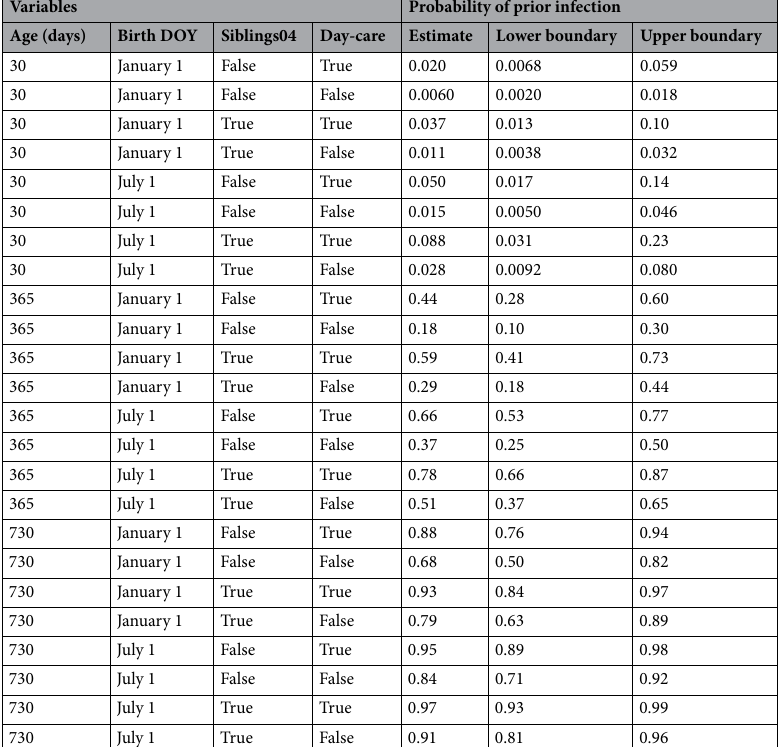
Table 1. Estimates of the probability of prior infection as function of age, birth DOY, having siblings age 0–4 and day-care visits. Shown are outcomes of the full model for a representative selection of combinations of variables. For each combination the estimate, lower and upper 95% confidence interval boundary is